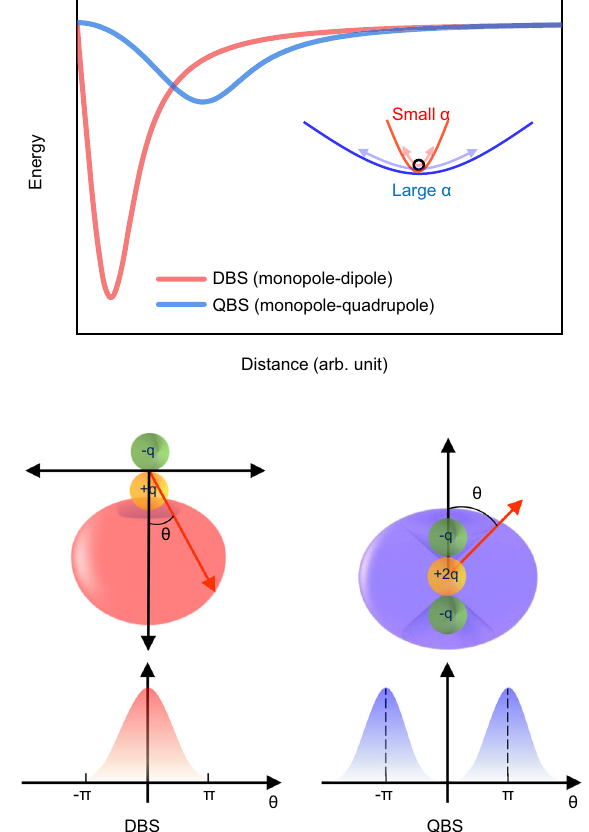
Fig. 4 Long-range potentials and associated charge distributions of DBS and QBS. a Long-range potential energy curves of the 4-BP − DBS (monopole-dipole, red) and 4-CP − QBS (monopole-quadrupole, blue) from the pseudo-potential functions given in Eqs. (4) and (5), respectively (see the text). Inset: the electron in the steep potential curve of the DBS exhibits the relatively smaller polarizability (small α ) in the external oscillating fi eld compared to that in the rather shallow potential curve of the QBS (large α ). b The depicted (expected) angular distribution of the DBS (left) or QBS (right) orbital. The DBS electron (left) is con fi ned in the narrow angular region at the positive side of dipolar molecule whereas the QBS electron is more widely distributed surrounding the molecular